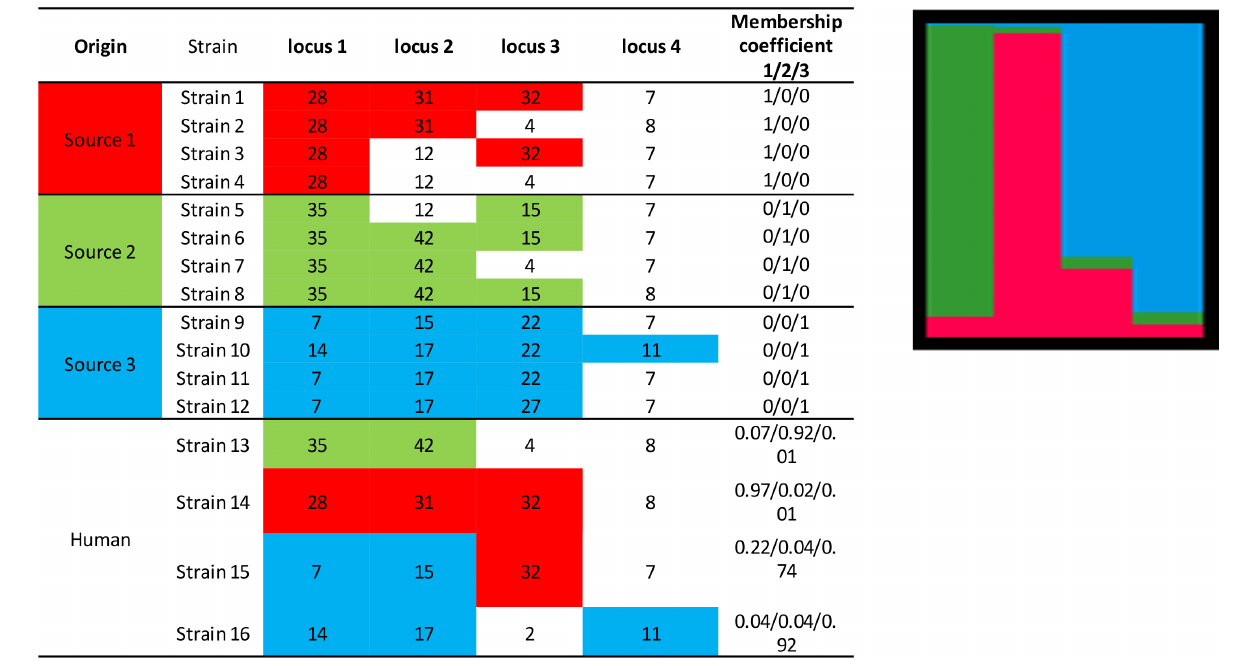
FIGURE 3 | Illustration of the approach for source attribution of the STRUCTURE model. Table: allelic profile of 12 strains from three sources (source 1 in red, source 2 in green, source 3 in blue) and four human strains. Bar chart: membership coefficients of the four human strains for the three sources. Each vertical bar represents a strain to be assigned. The relative lengths of the color bars for a strain are proportional to the membership